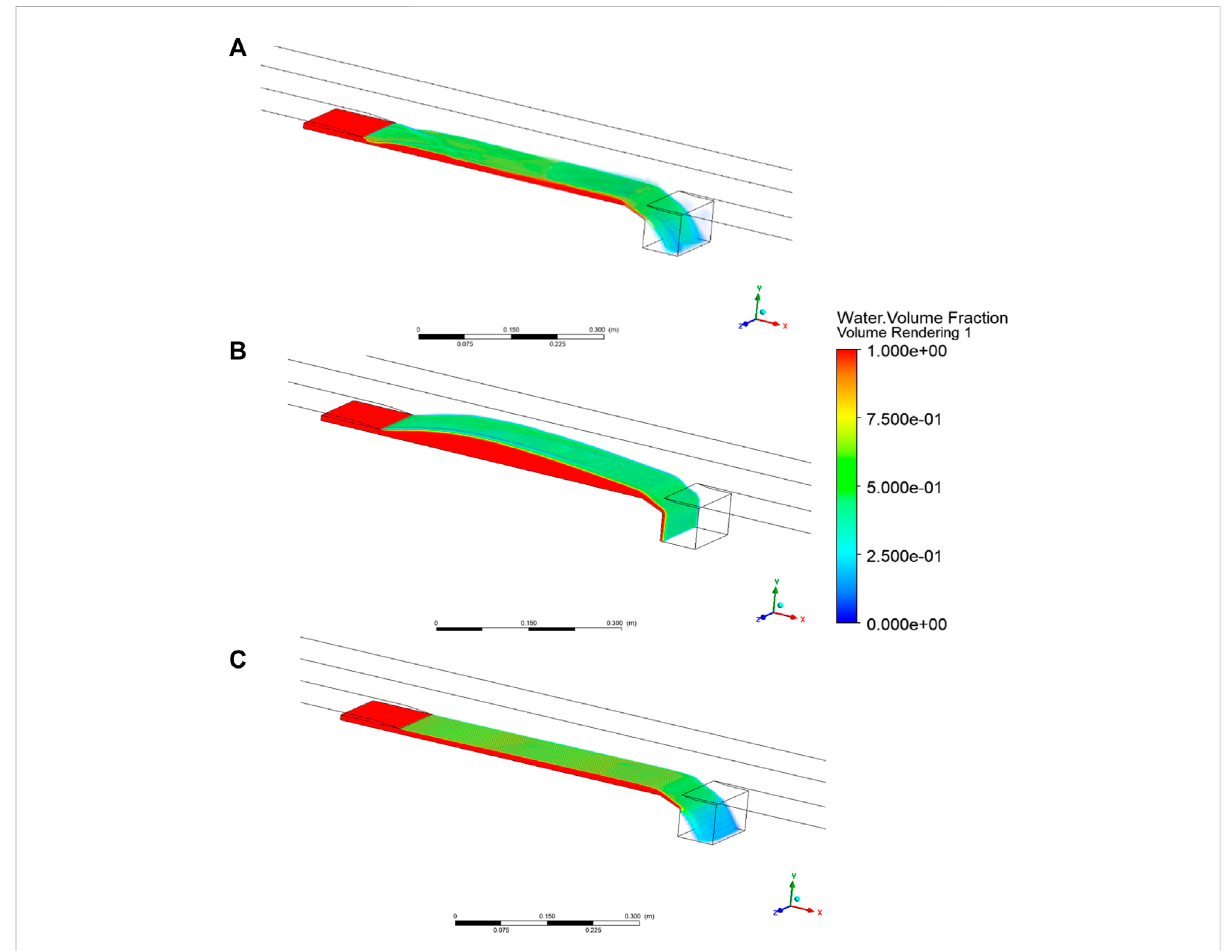
FIGURE 11 The contour of the phase fraction α G , (A) Run 2, (B) Run 3 and (C) Run